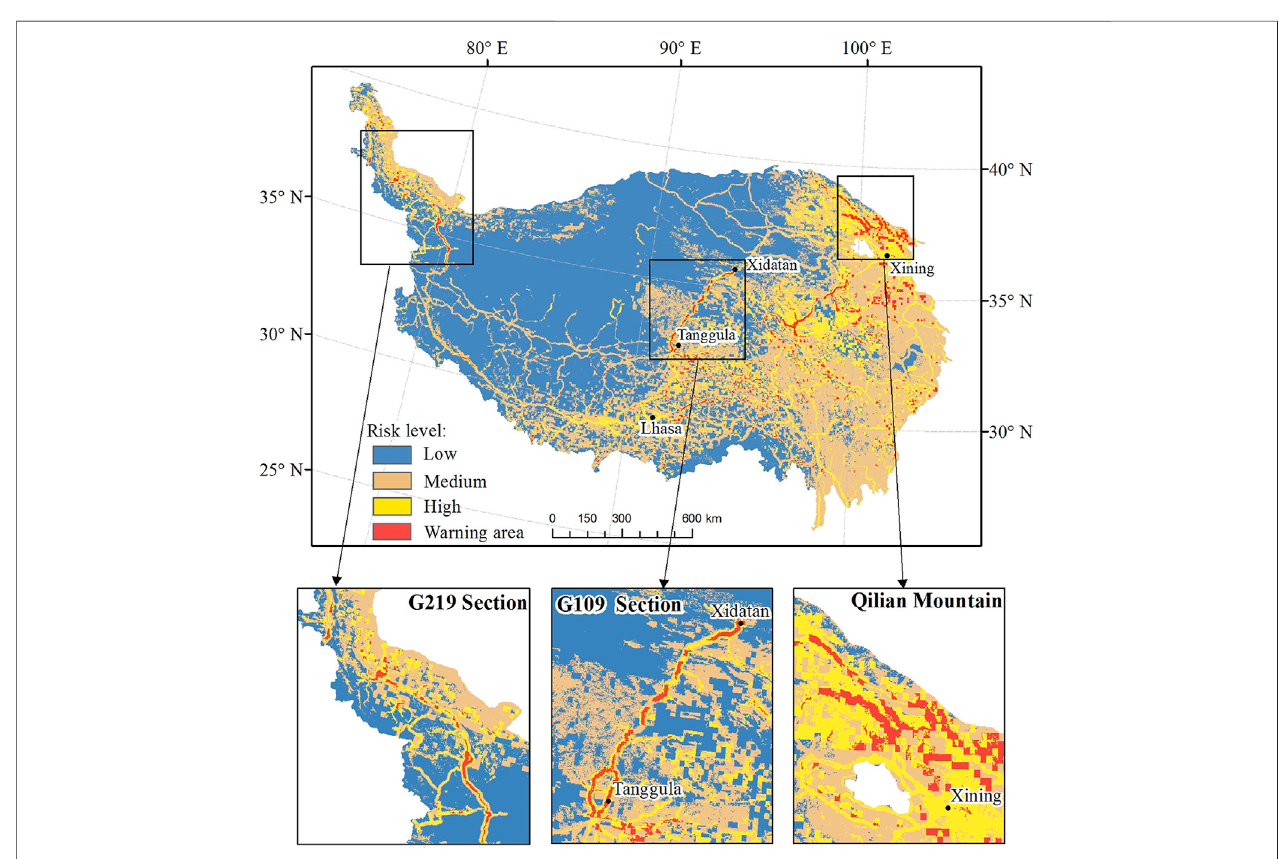
FIGURE 7 | The thawing disaster warning map of the frozen ground of the QTP.